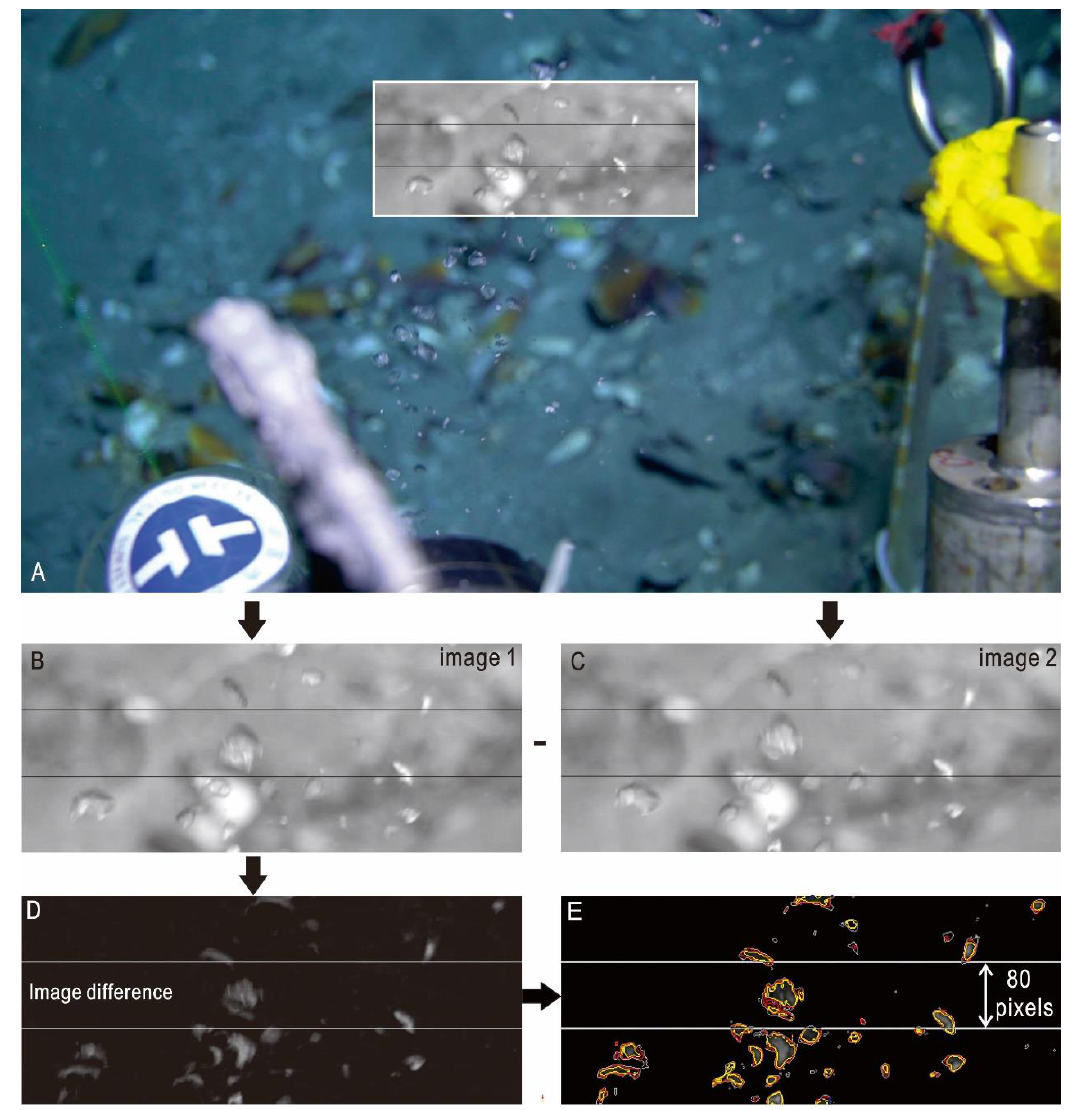
Figure 3. Schematic diagram depicting the image-processing method using the semi-automatic bubble counting algorithm. ( A ) Original image from which a cropped bubble counting area is determined and converted to grayscale. The cropped bubble counting area is subtracted from the consecutive image ( B , C : frames 1 and 2) to delete a constant background and identify bubbles (bright spots in D ). Three thresholds (high, medium, and low) were used to identify bubbles to account for bubble size, motion blurring, and oil content. ( E ) Bubbles are counted and subsampled in the counting region. Bubble count for each pixel line is summed across every frame in a clip, and total line counts are averaged to generate three values of bubble release for each threshold (high, medium, low) for one clip. This sequence was repeated for each clip to create a time series of bubble release for the entire deployment time.